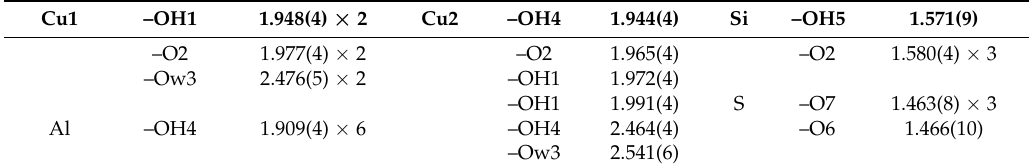
Figure 3. Projection of the crystal structure of tiberiobardiite viewed down b ( a ) and c ( b ). Polyhedra: green = Cu1 and Cu2 sites; light blue = Al site; blue = Si site; and yellow = S site. Circles: light blue = H 2 O groups; blue = OH; and red = O. Table 5. Selected bond distances (in Å) in